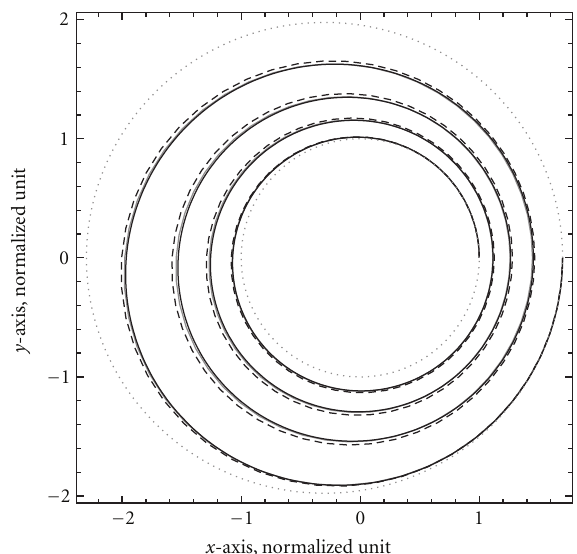
Figure 7: Visual comparison of di ff erent trajectories in case D.